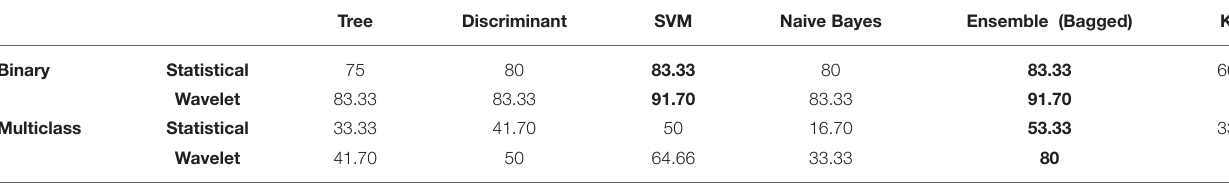
TABLE 2 | Testing accuracy obtained using various machine learning techniques.